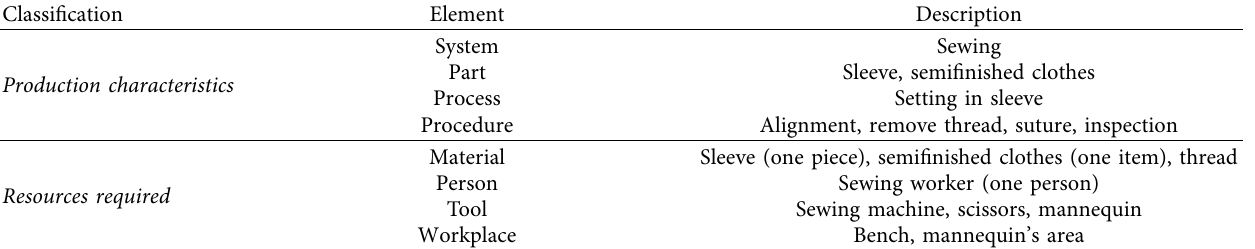
Table 7: Description of the sleeve setting process.